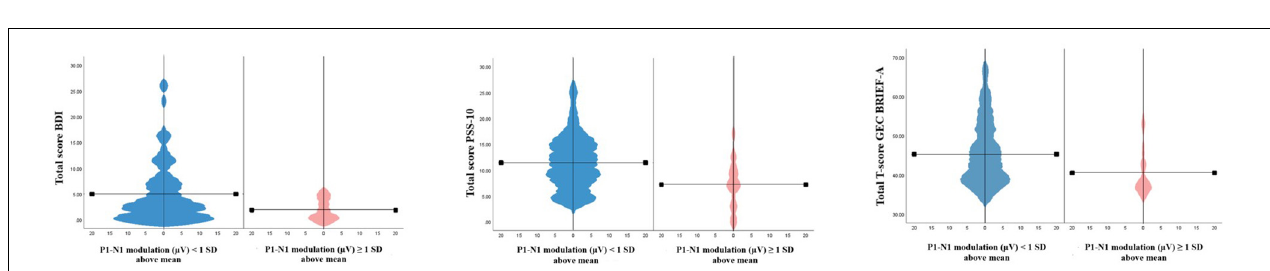
FIGURE 5 | Scatterplots showing associations between VEP Plasticity (C1, P1, N1, and P1-N1) and self-reported depressive symptoms (A) , perceived stress (B) , and executive dysfunction (C) .